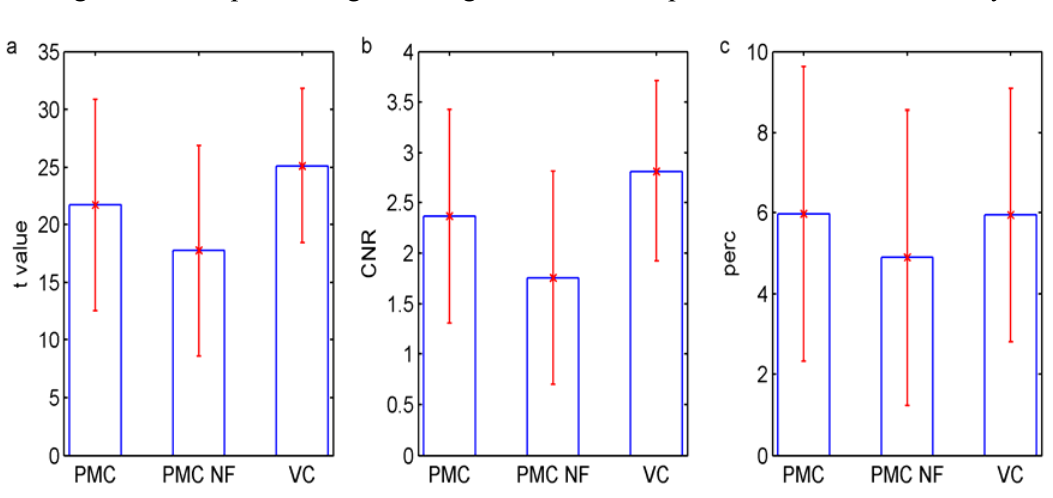
Figure 5. fSVPS quality measures. Average ( a ) t-value; ( b ) contrast to noise ratio(CNR); and ( c ) percent signal change (blue bars ± SD in read) show similar patterns across the PMC, PMC NF, and VC conditions. The SVPS approach provides robust statistics based on its high CNR and percent signal change. Note that the panels are scaled